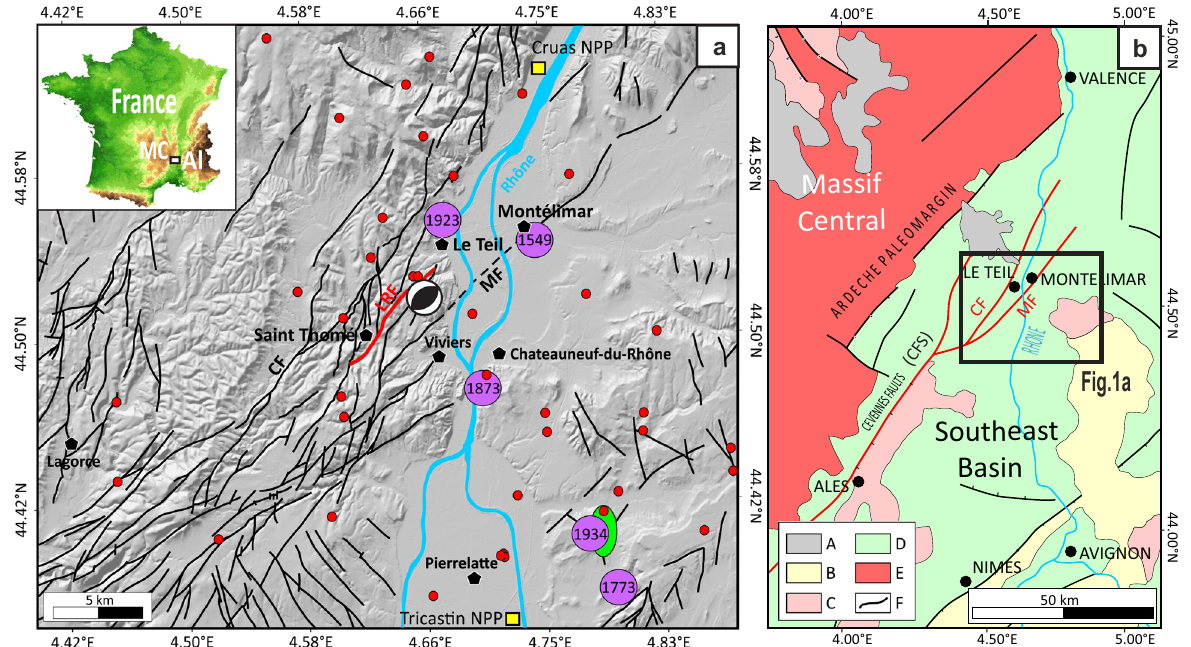
Fig. 1 Structural and seismotectonic setting of the 11 November 2019 Le Teil earthquake. a Seismotectonic map of the Rhône River Valley where occurred the 11 November 2019 M w 4.9 Le Teil earthquake (44.518°N and 4.671°E). The black and white sphere indicates the reverse-faulting focal mechanism; red and purple circles are instrumental and historical seismicity, respectively; the green ellipse corresponds to the Tricastin swarm; black lines are faults from the Aubenas geological map 4 with the La Rouvière Fault (LRF) in red. CF Cévennes Fault, MF Marsanne Fault. The shaded DTM is from BD ALTI 25 m (IGN); MC and Al in the inset are Massif Central and Alps, respectively. b Simpli fi ed geological map of the western boundary of the Southeastern Basin (modi fi ed from refs. 7,44 ). A: Plio-Quaternary volcanism; B: Miocene – Pliocene sediments; C: Oligocene sediments; D: Mesozoic sediments; E: Paleozoic crystalline basement (Massif Central); F: major faults (NE termination of the Cevennes fault system (CFS) in red, CF and MF for Cévennes Fault and Marsanne Fault, respectively). Black dots indicate main population